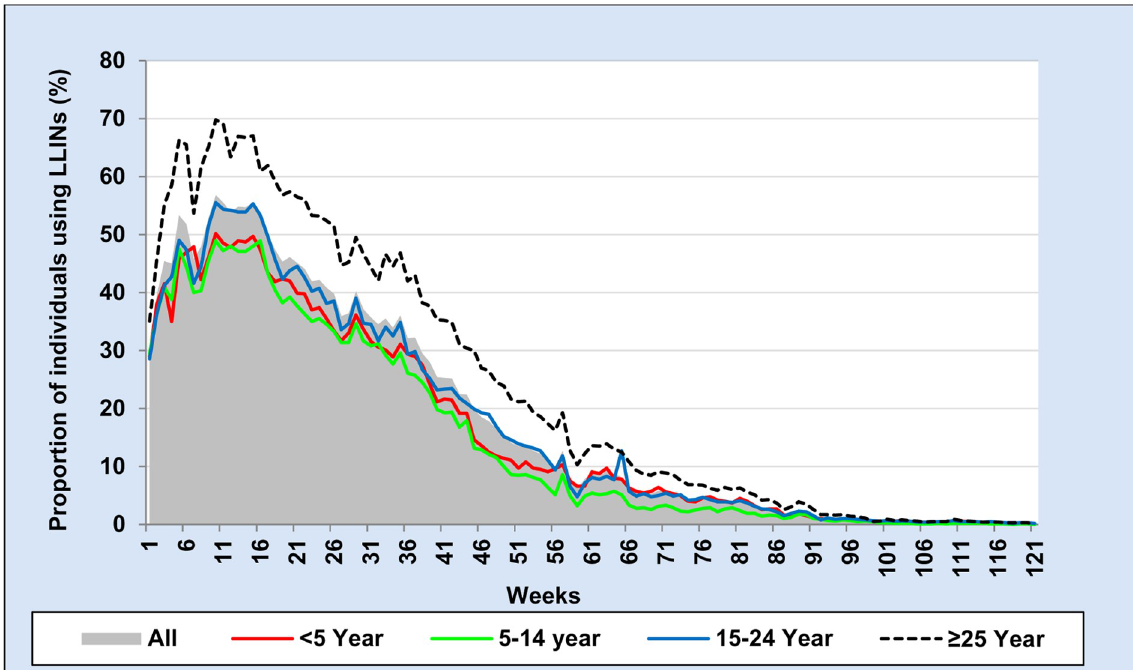
Fig 4. Weekly proportion of individuals using long-lasting insecticidal net by age group during 121 weeks from October 2014 to January 2017.